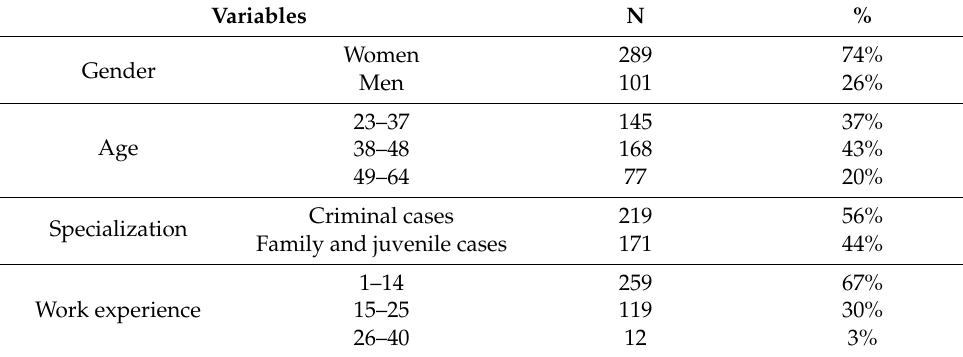
Table 1. Demographic characteristics of the